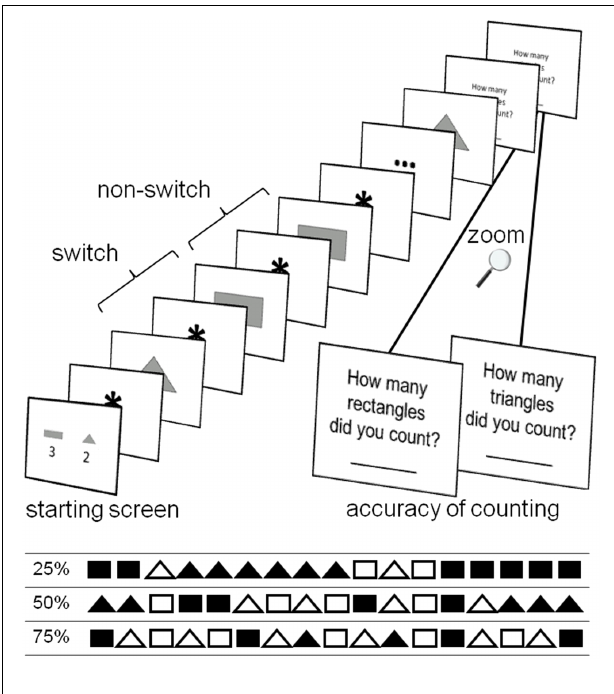
FIGURE 1 |An illustration of the continuous counting task: the top of the figure illustrates the sequence procedure in the continuous counting figures task with starting values of 3 for rectangles and 2 for triangles, an exemplary counting sequence, and the two accuracy screens. The bottom of the figure gives examples for sequences of the three frequency classes (light objects mark